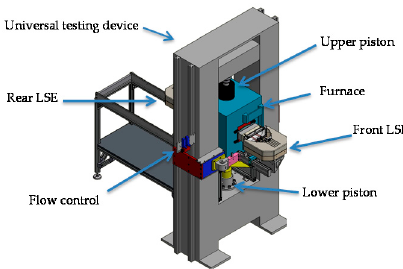
Figure 2. High-temperature testing device (courtesy of Messphysik).